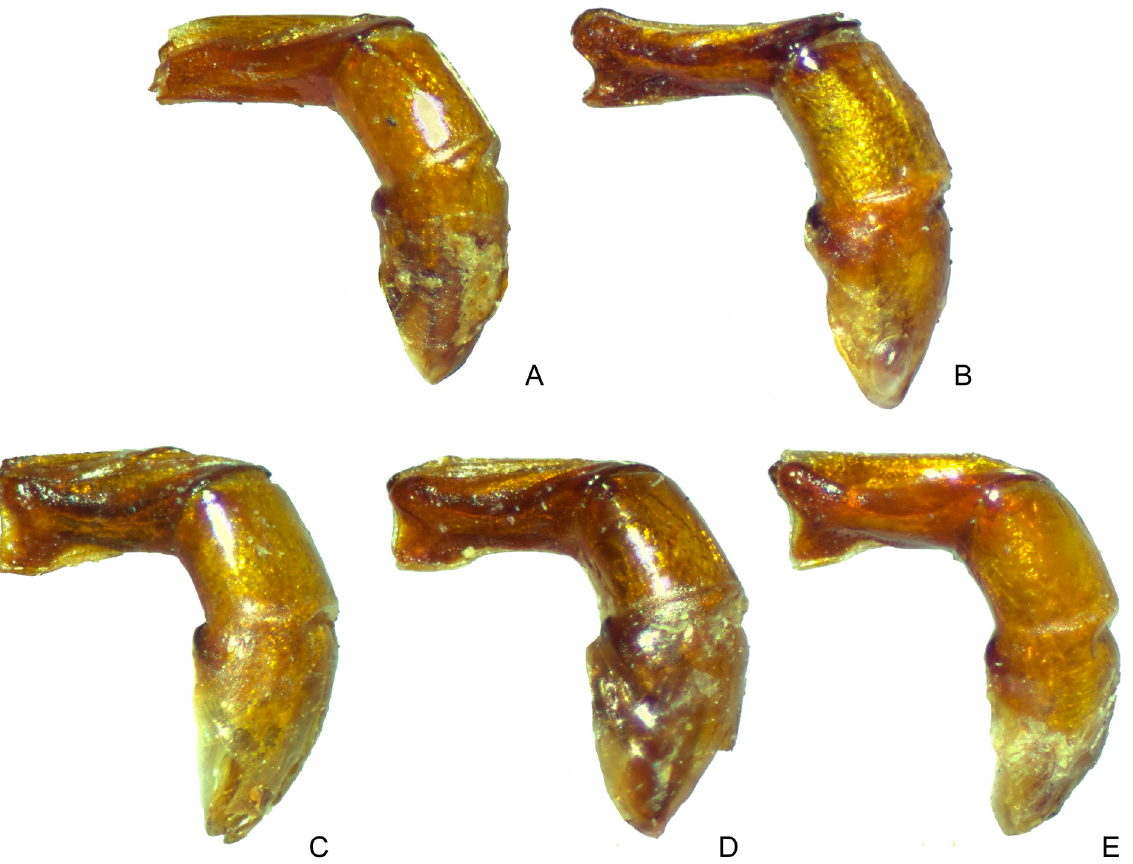
Fig. 19. Aedeagus morphological diversity in Sylvicanthon . A . S. securus (Schmidt, 1920) comb. nov. B . S. obscurus (Schmidt, 1920). C . S. furvus (Schmidt, 1920) . D . S. monnei sp. nov. E . S. mayri sp.